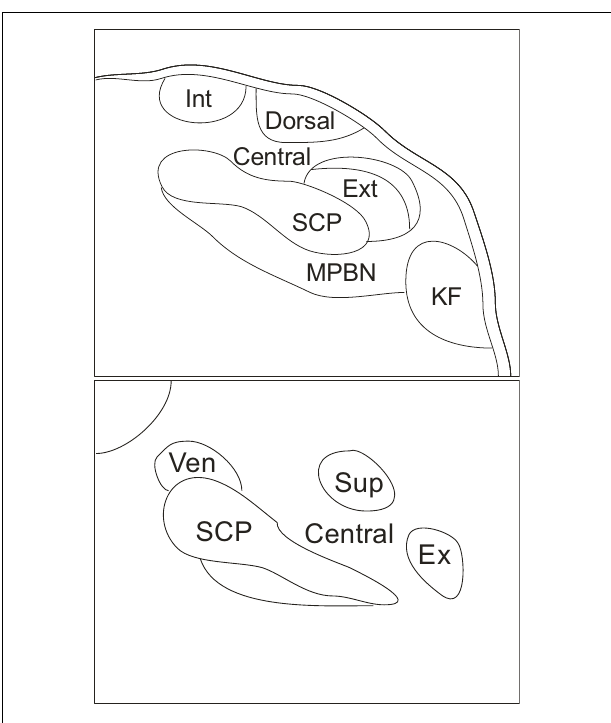
FIGURE 1 | Schematic indicating coronal organization of the parabrachial nucleus surrounding the superior cerebellar peduncle. Top panel illustrates caudal parabrachial nucleus and lower panel illustrates rostral parabrachial nucleus. Abbreviations: central, central lateral subnucleus; dorsal, dorsal lateral subnucleus; ex, extreme lateral subnucleus; ext, external lateral subnucleus; int, internal lateral subnucleus; KF, kolliker fuse nucleus; MPBN, medial parabrachial nucleus; SCP, superior cerebellar peduncle; sup, superior lateral subnucleus; ven, ventral lateral